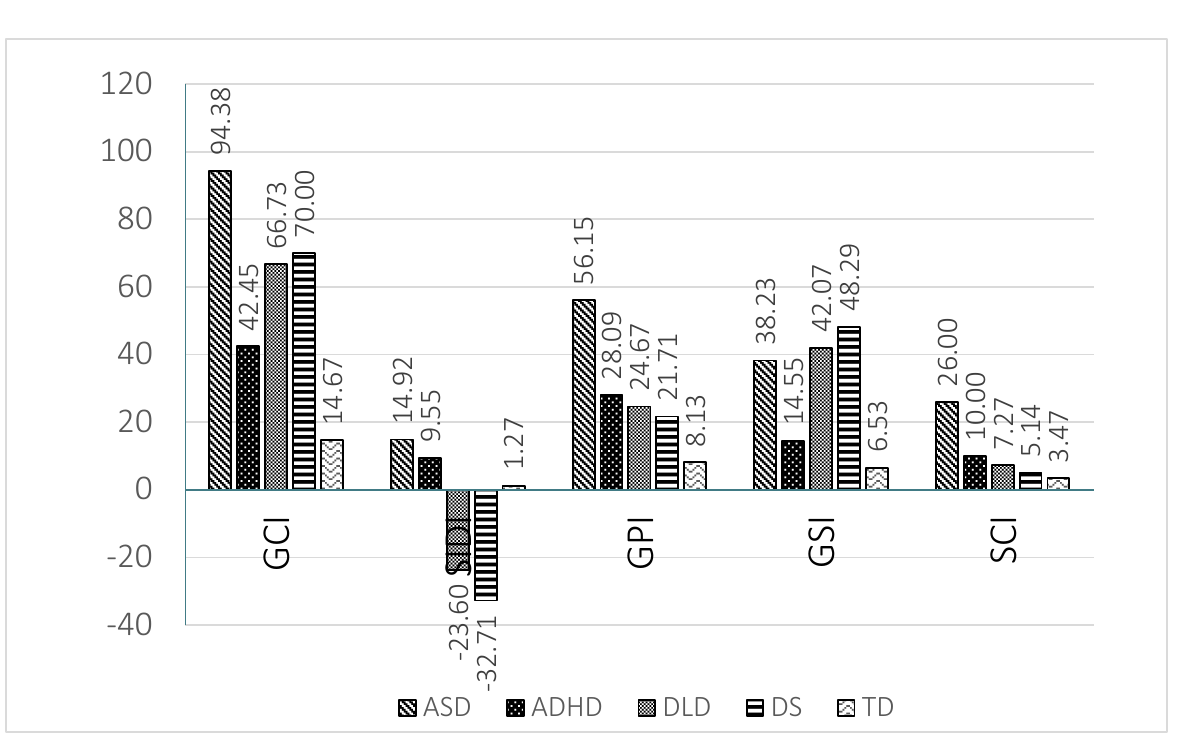
Children 2021 , 8 , x FOR PEER REVIEW Figure 3. Means obtained by the 5 groups at preschool age in the indices of the Galician CCC-2.